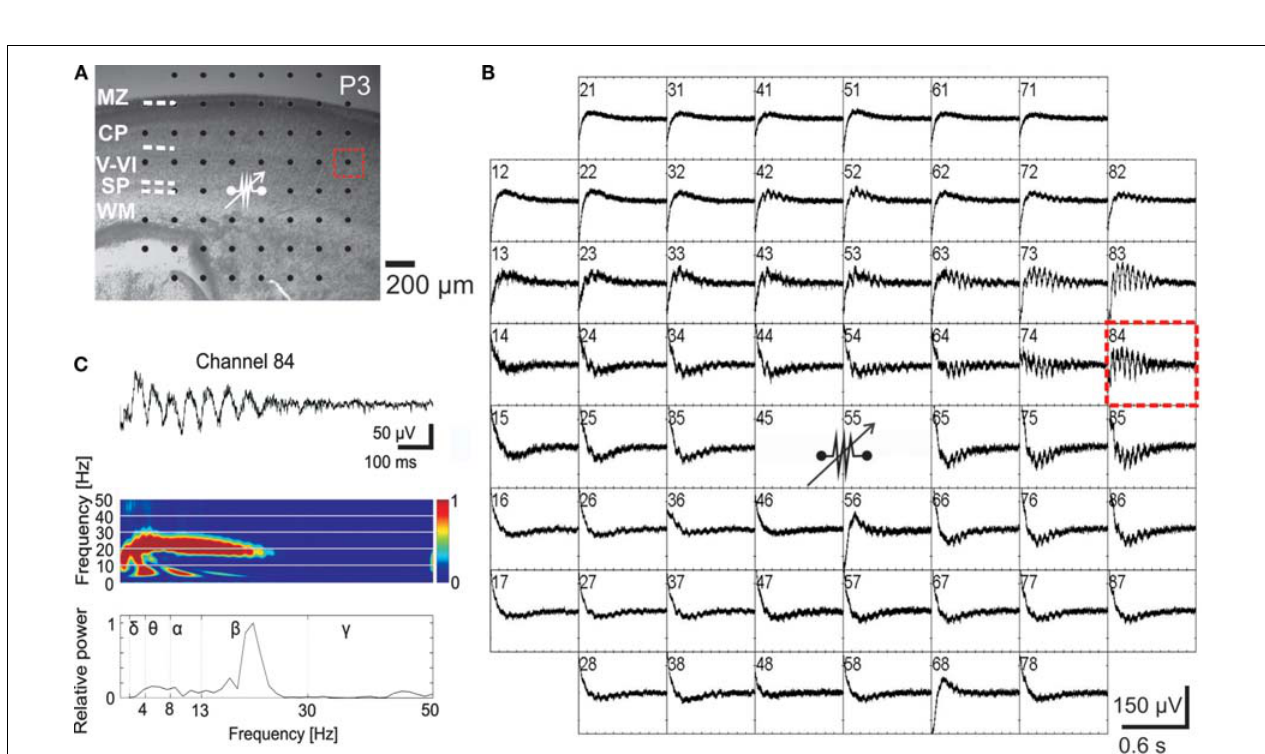
section below. (B) Lack of carbachol-induced activity in a cortical slab preparation, in which the subplate was eliminated. The absence of the subplate was verifi ed by Nissl staining. Reproduced with permission from Dupont et al. (2006).